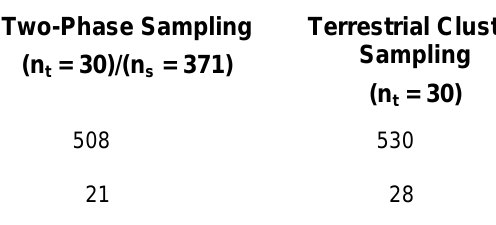
Comparison of the Estimate of Stand Volume Based on Two-Phase Random Sample Tests and Terrestrial-Only Cluster Samples in Lenga Forest Stratum